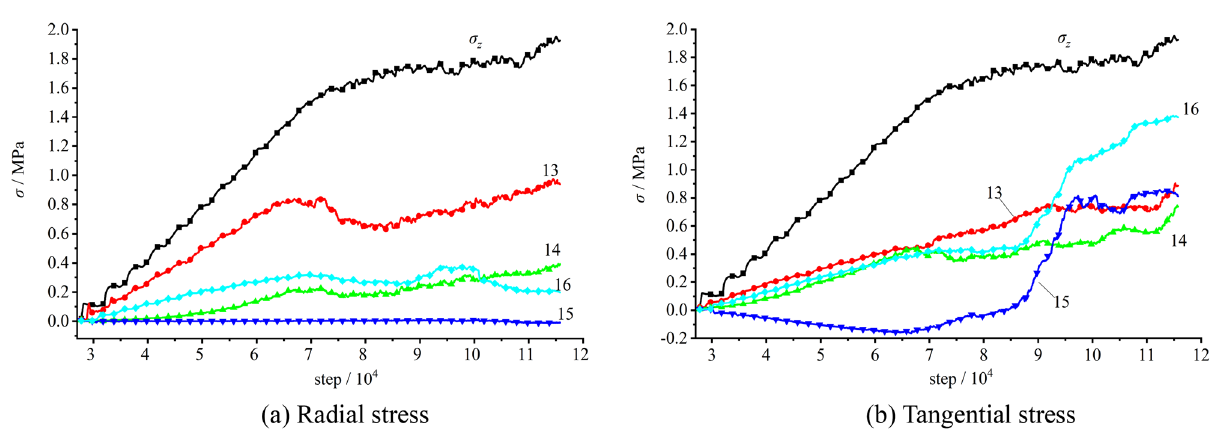
Figure 20. Stress variation of the measuring element on the vertical sidewall during the loading testing.